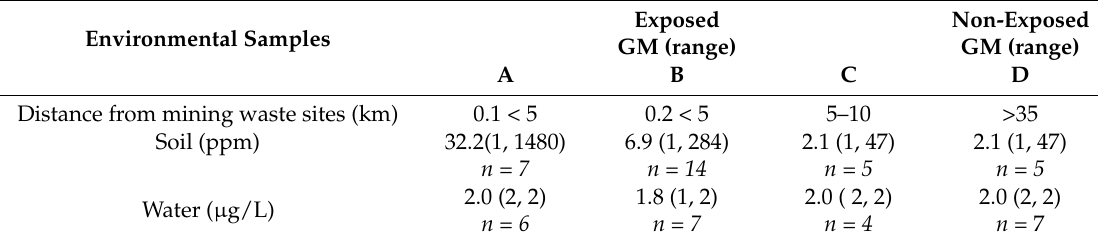
Table 1. Lead concentration in environmental samples of populations near mining waste sites.